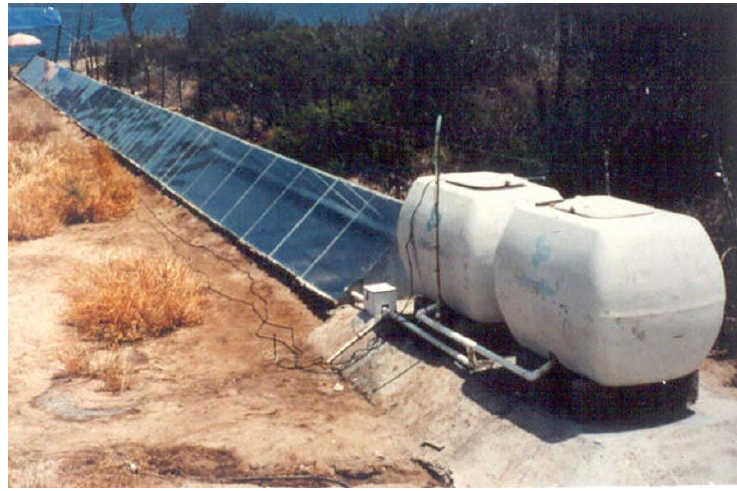
Figure 16. Double slope solar still with ferrocement basin.